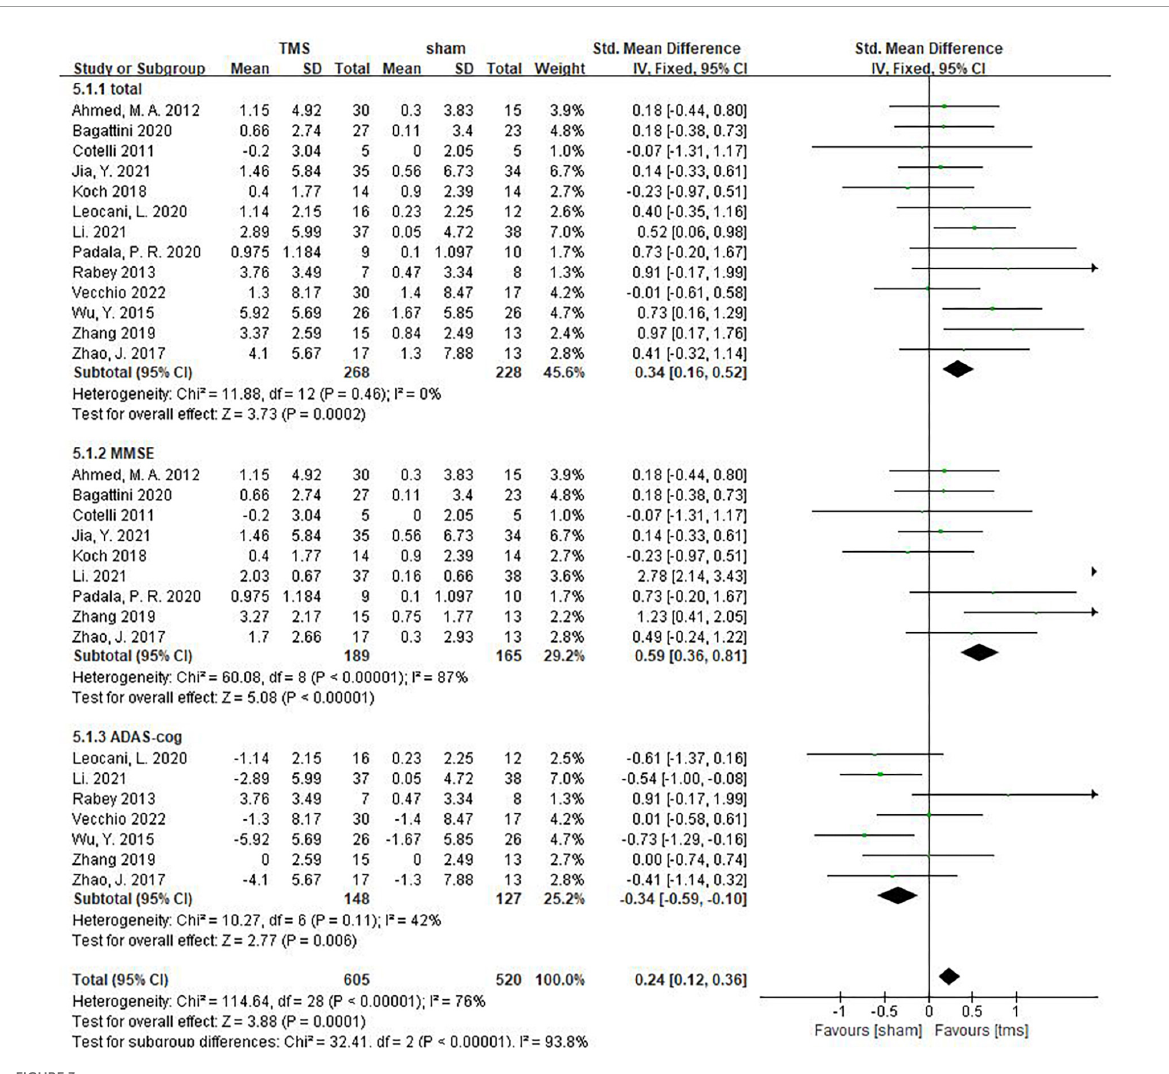
calculation of the results of ADAS-cog, MMSE, MoCA and WHO-UCLA AVLT